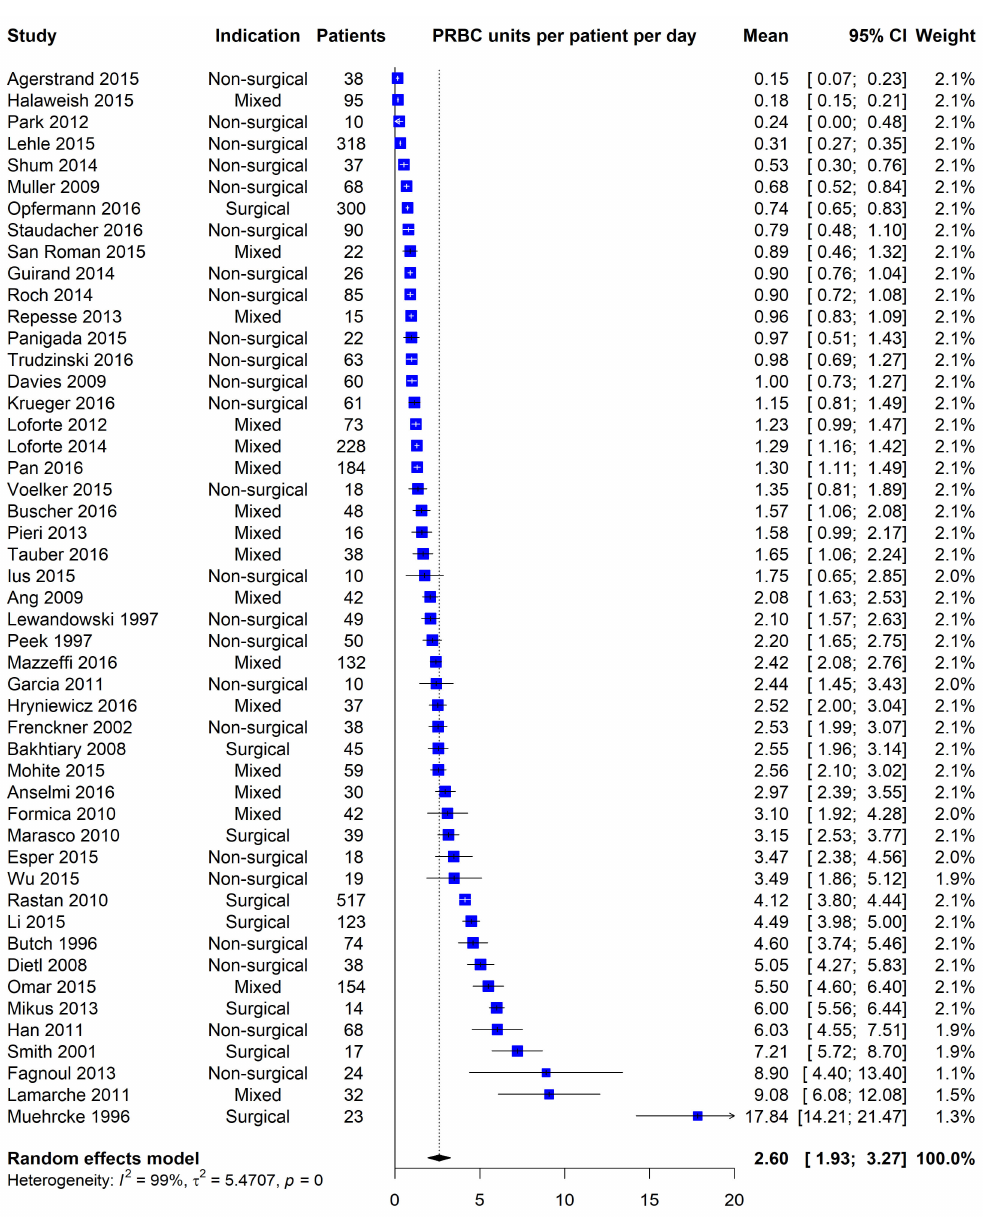
Figure 2. Forest Plot-all included